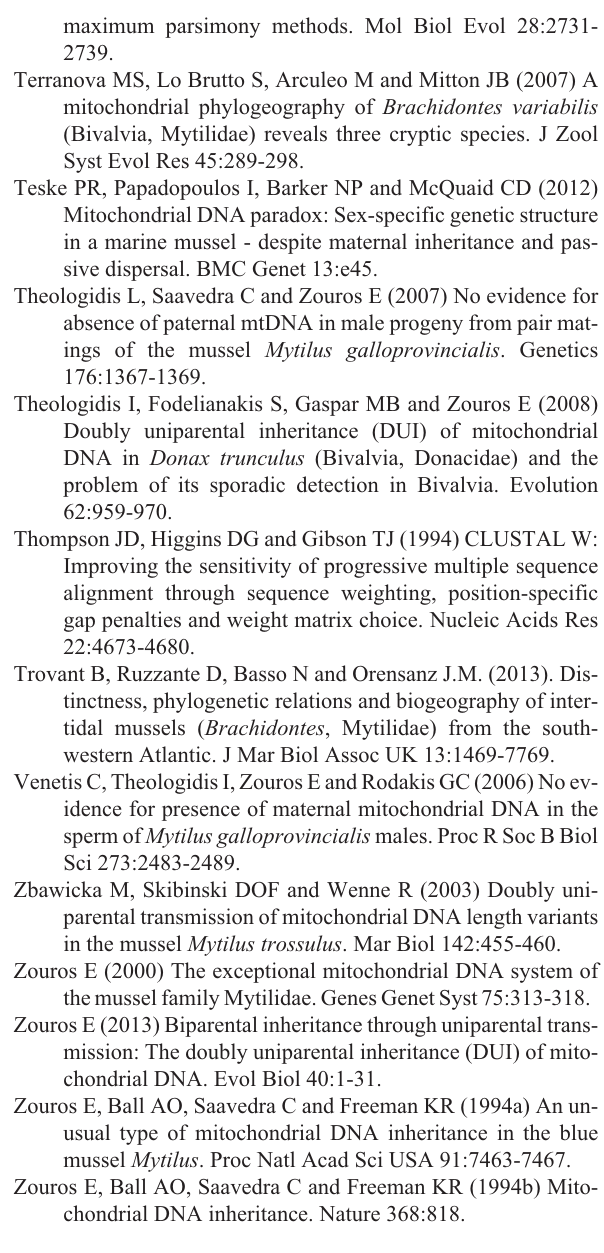
Figure S1 - Phenograms showing amplification of two genomes from one individual. Figure S2 - Alignment of all sequences used for phylogen- etic